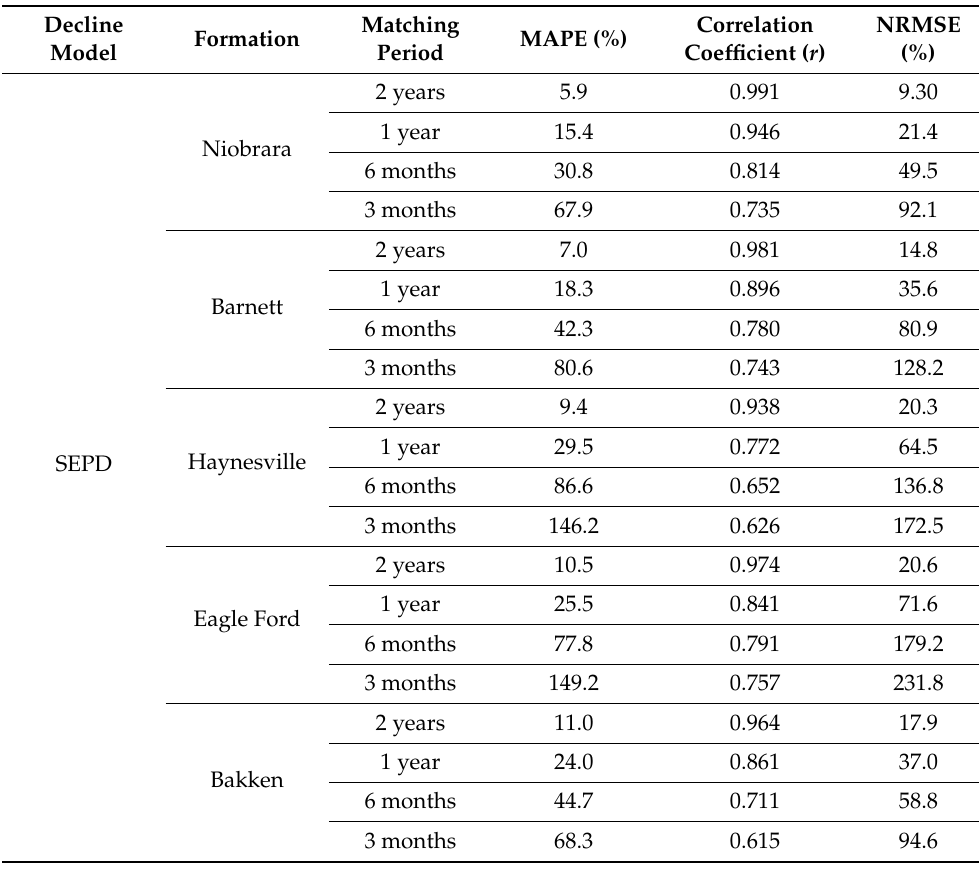
Table 6. Results from production history matching on all wells from each formation using different production data periods with the SEPD model.